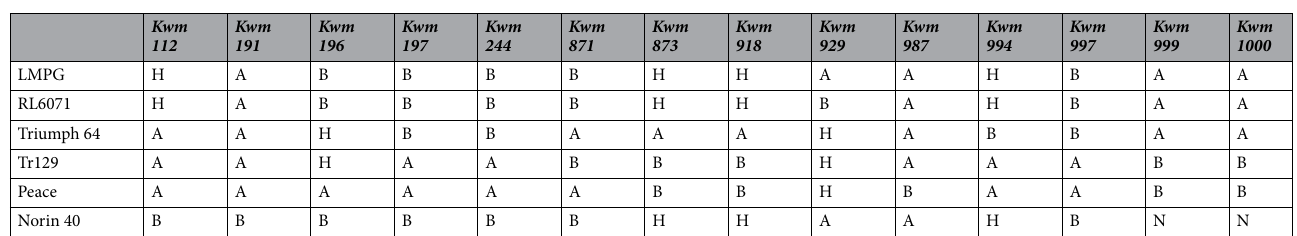
Table 3. SNP marker haplotypes of wheat lines Triumph 64, Tr129, Peace, and Norin 40 with genes for stem rust resistance on chromosome arm 6DS and susceptible lines LMPG and RL6071. A allele 1, B allele 2, H heterogeneous, N